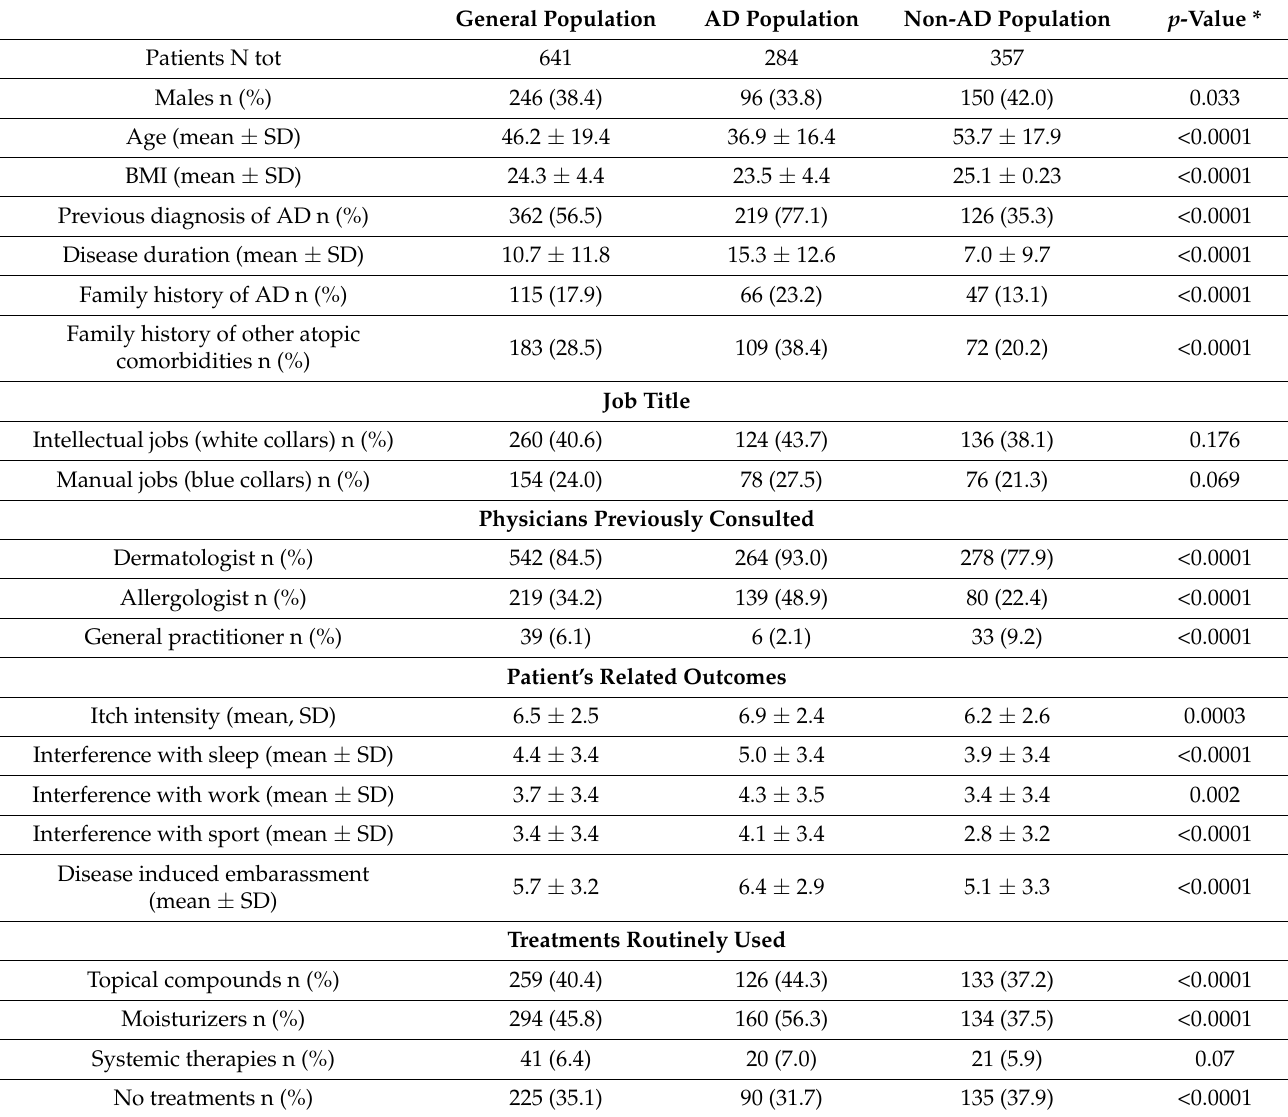
Table 1. Characteristics of general population, and separately for atopic dermatitis (AD) and non-AD. General Population AD Population Non-AD Population p -Value